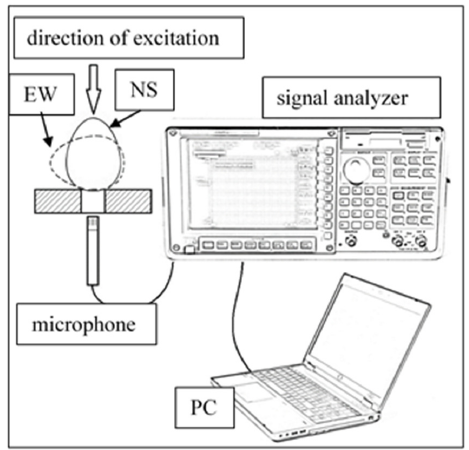
Figure 4. Experimental setup for the acoustic measurement of eggs in two positions. After removing erroneous measurement files, the total number of processed measure- ments was 693. The signals were first cropped to length dictated by the desired window